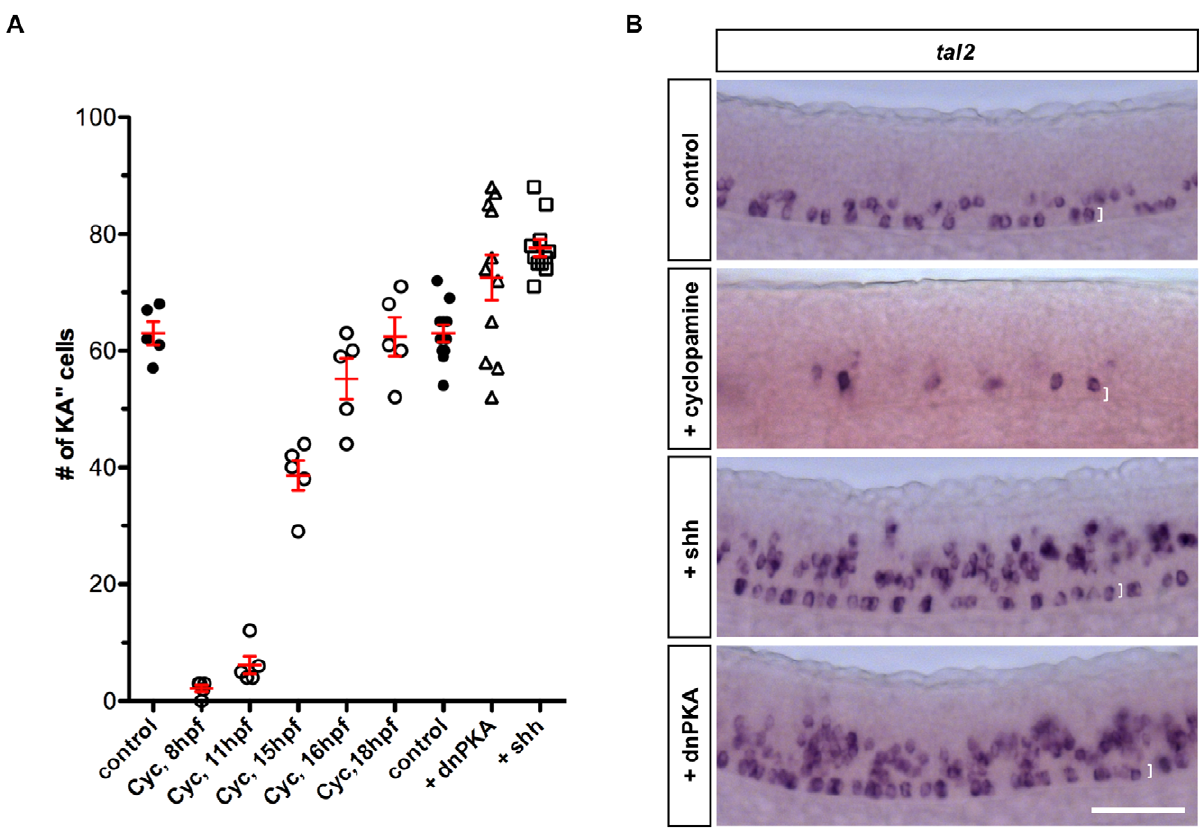
Figure 4. KA 0 specification depends on Hh signaling. (A) Quantification of the total number of KA 0 cells at 24 hpf under different conditions. Cyclopamine (Cyc) was treated from indicated stage until 24 hpf. Embryos injected with dnPKA or Shh mRNA showed increase in total number of KA 0 cells compared to uninjected control embryos. (B) Cyclopamine-treated embryos (from 8 hpf to 24 hpf) abolished tal2 expression in the LFP domain, while overexpression of dnPKA and Shh induced ectopic tal2 + cells. Note that the few tal2 + cells in cyclopamine-treated embryos are located dorsal to the LFP domain. Images shown are lateral views of embryos at 24 hpf. The dorsal-ventral extent of the LFP domain is indicated by brackets. Scale bar: 50 m m.